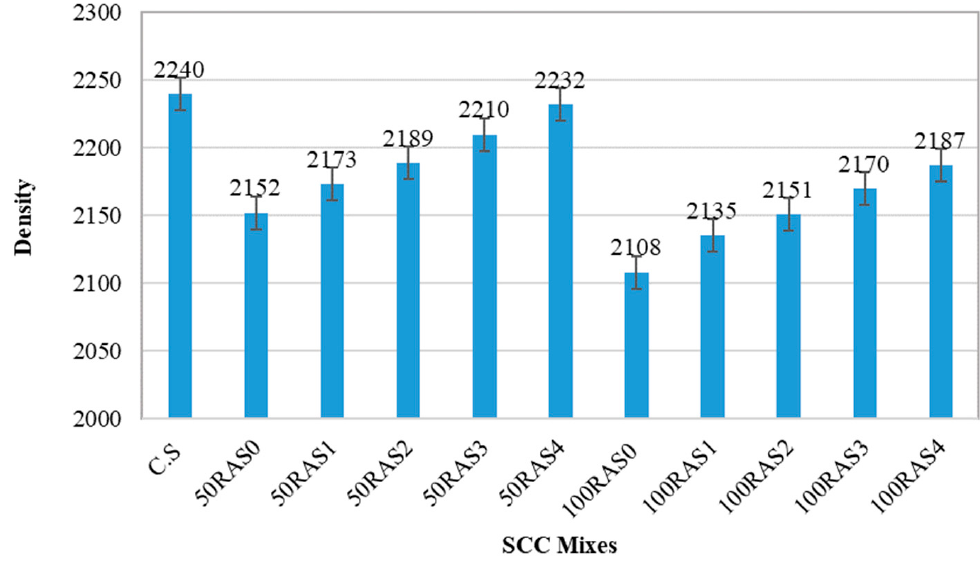
Figure 8. The average density of SCC mixes .